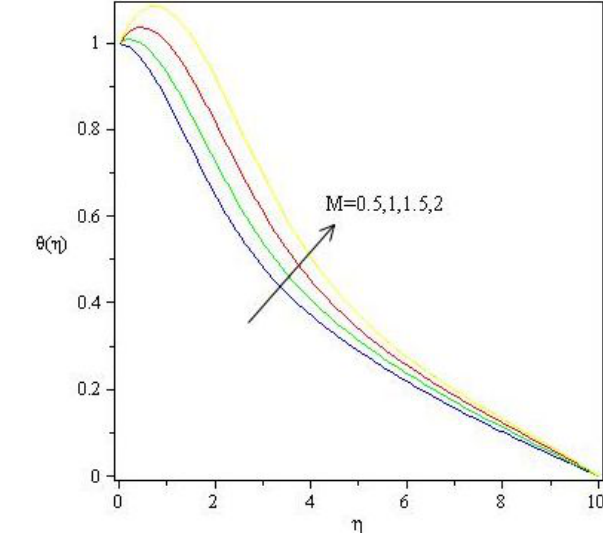
Fig. 13: Temperature profile for different values of n and different parameters p = 1, M = 0, A = −0.05, B = −0.05, pr = 1